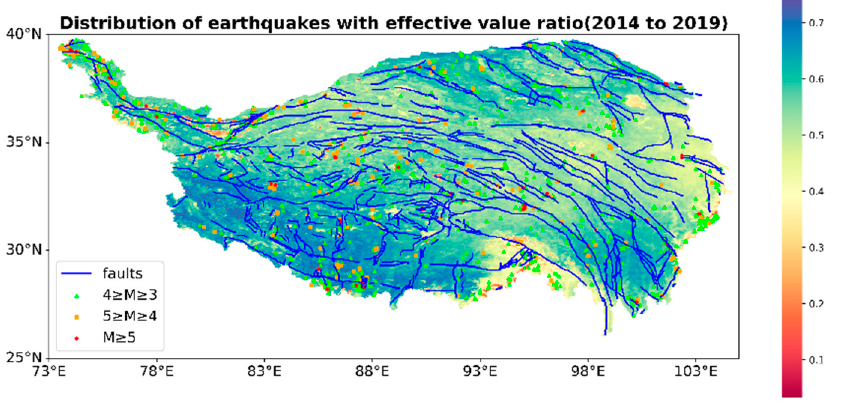
Figure 1. The spatial distribution of earthquakes and faults from 2014 to 2019. The note on the right indicates the frequency of pixels not covered by clouds of the raw TIR data in the selected period.